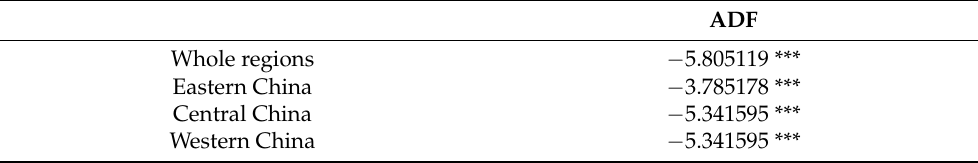
Table 5. Kao test results of panel